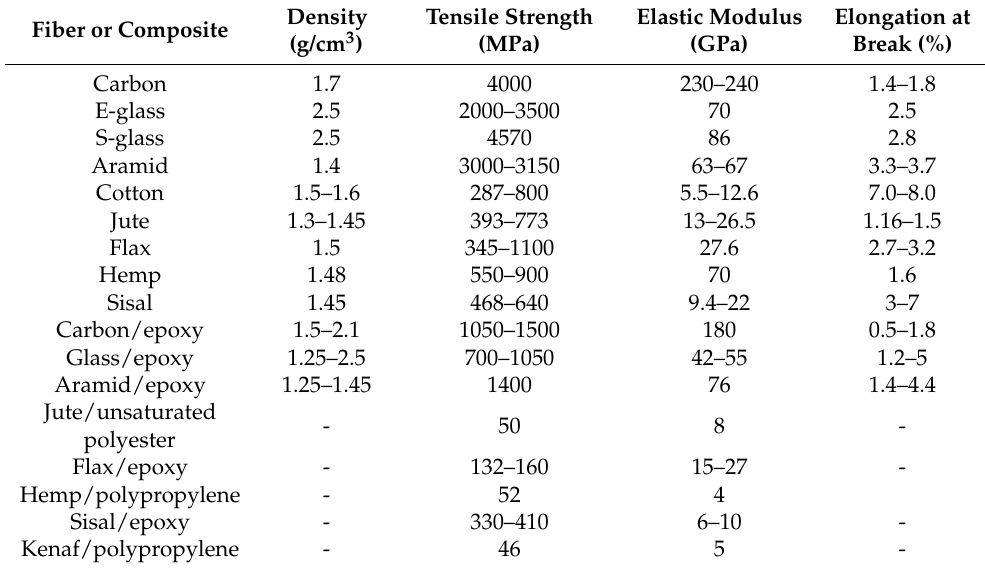
Table 1. Room temperature material properties of synthetic and natural fibers and their composites. Fiber or